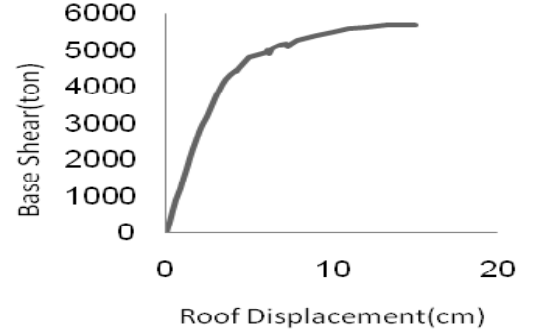
Fig. 5. Base shear - roof displacement curve for five story structure